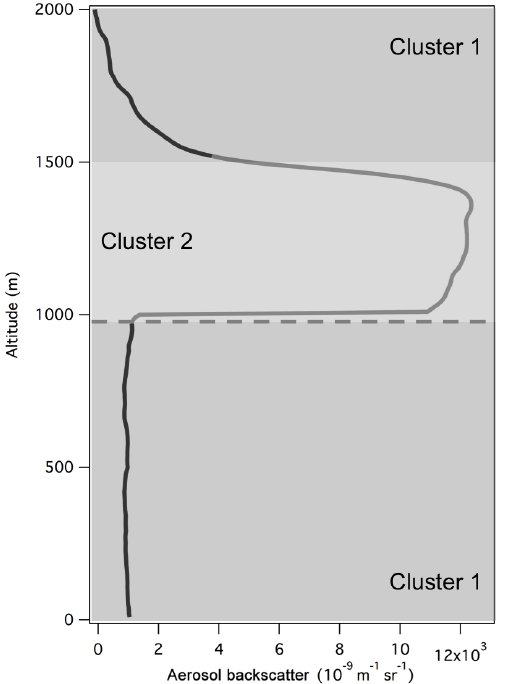
Figure 12. Cluster assignments of aerosol backscatter profile with cloud layer at about 1000–1520m on 15 September 2013 measured at 11:00CST. Automated BLH was found at 970m.